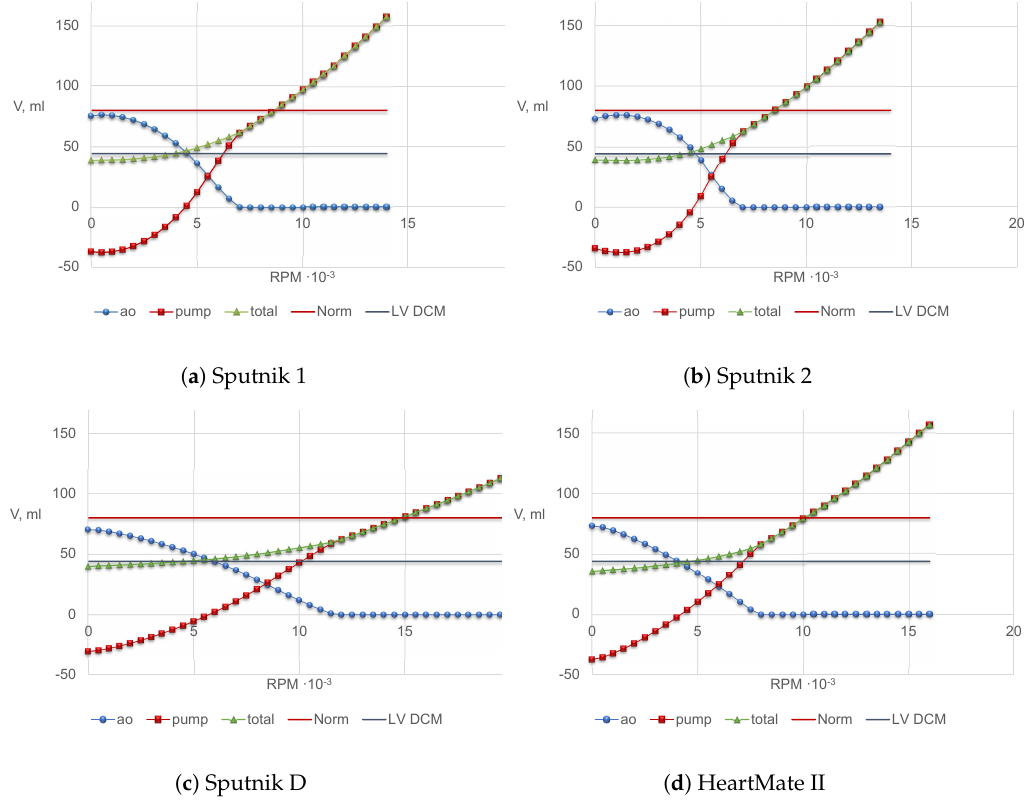
Figure 5. Ejected volume per cardiac cycle through the aortic valve, through the pump and the total value for the segment II of the aorta (see Figure 1). Norm—normal (healthy) value, LV DCM—left ventricular dilated cardiomyopathy value without pump.